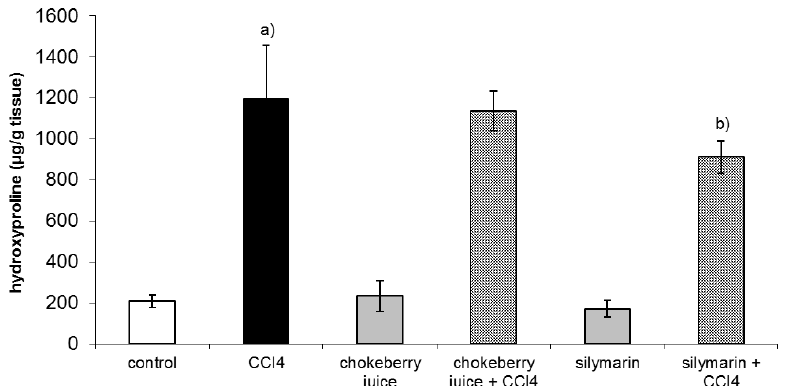
Figure 1. Effect of chokeberry juice or silymarin on hydroxyproline content in the liver of rats treated with CCl 4 . Results are means ± SD, n = 8. a) significantly different from control, p < 0.05; b) significantly different from CCl 4 -treated rats, p < 0.05.